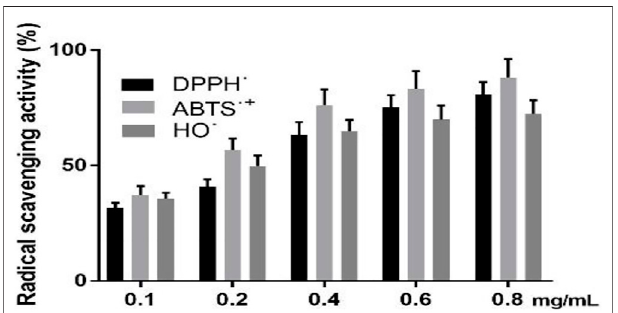
FIGURE 2 | Radical scavenging activity of DPPH _ , ABTS _ + and OH _ . Data are shown as means ± SD (n (cid:2) 3).